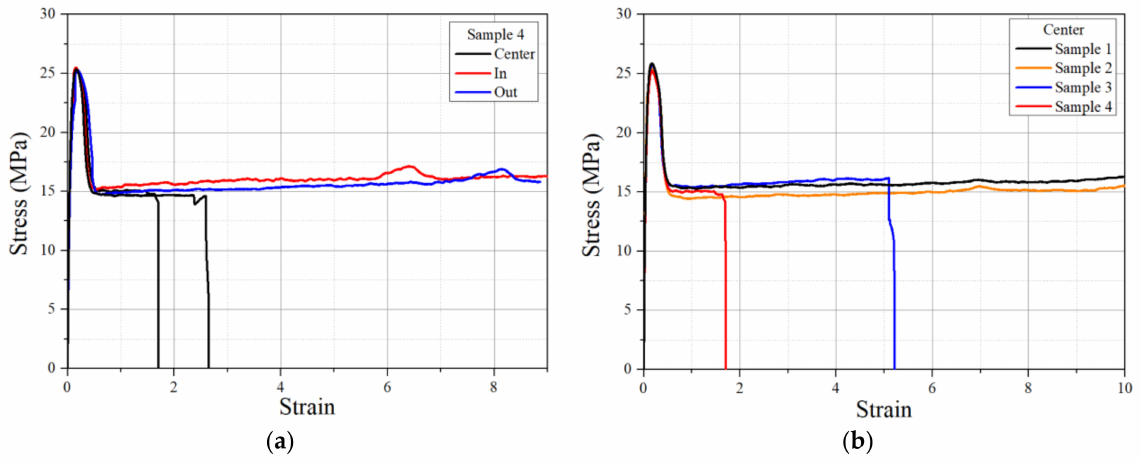
Figure 12. Stress–strain curves of ( a ) 3.5 mm-thick specimens taken from the inner, mid, and outer walls of sample 4 and ( b ) specimens from the center wall of all pipe